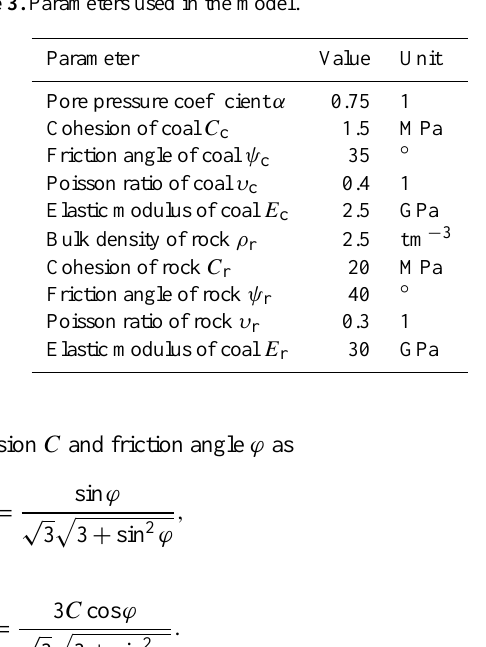
Table 3. Parameters used in the model.